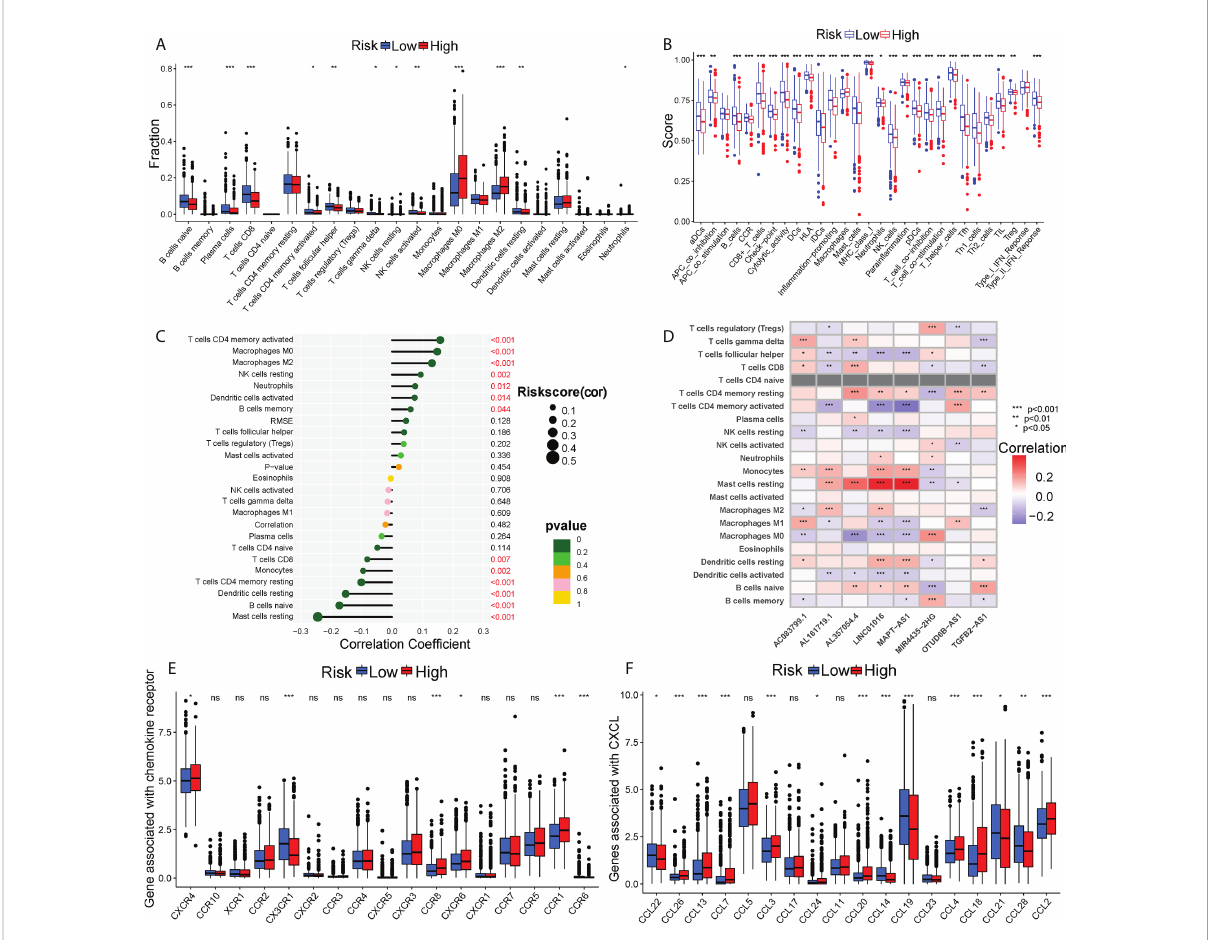
FIGURE 4 The immune landscape between two risk subgroups. (A) Differential immune in fi ltrates of 22 immune cell types. (B) 13 related immune pathways. (C) The correlation of risk score and immune cells. (D) The heatmap showing the correlation of 8 GT-lncRNAs with immune cells. The distinct expressions of chemokine receptors (E) and chemokines (F) between two risk groups. *P < 0.05, **P < 0.01; ***P < 0.001; ns, no signi fi